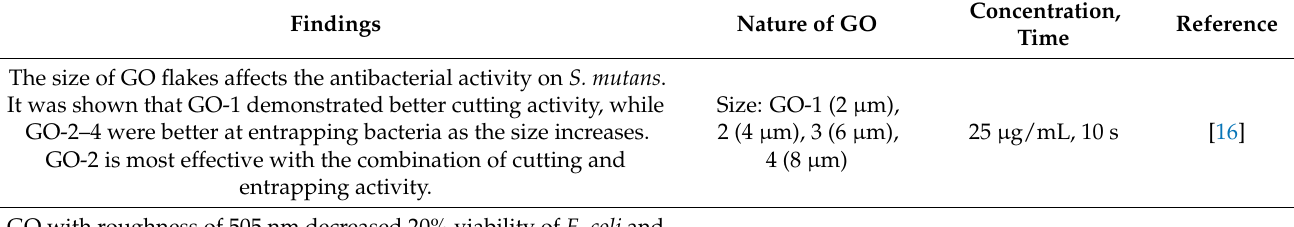
Concentration, Time